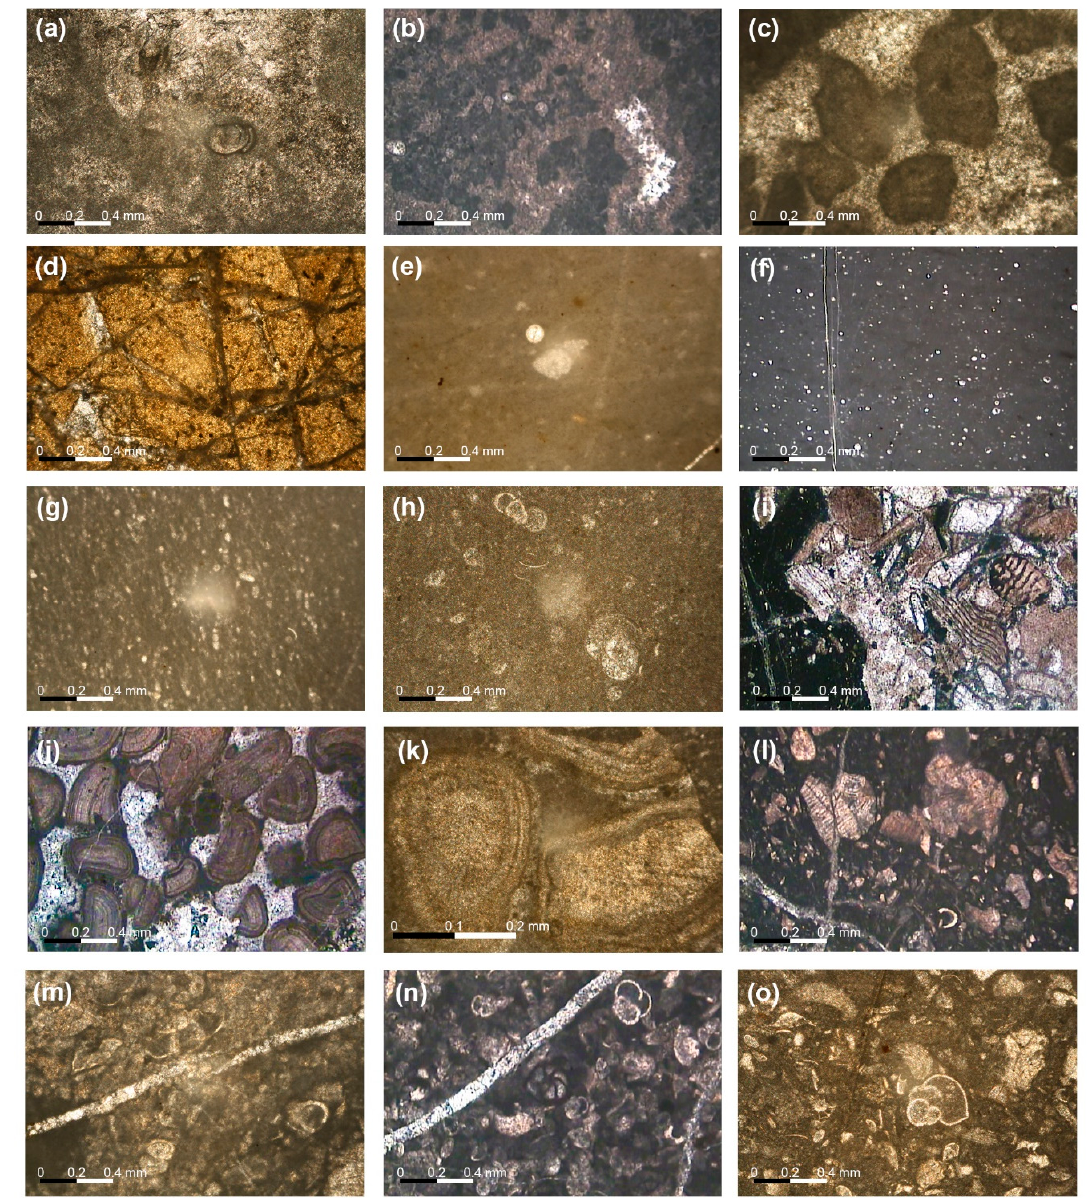
Figure 6. Characteristic Early Jurassic to Paleogene microfacies types of Ionian zone (Epirus region, NW Greece). ( a , b ) Dolomized boundstone with calcareous algae and benthic foraminifera within a micritic clotted matrix (samples AG1, AG15); ( c , d ) recrystallized grainstone of peloids with signals of dolomitization and fracturing (samples P3, P9); ( e ) mudstone-wackestone with radiolarian and planktonic foraminifera (sample P19); ( f , g ) wackestone with radiolarians (samples B1, B10); ( h ) Pelagic wackestone with radiolarians and planktonic foraminifera (sample K2); ( i ) Allochthonous bioclastic packstone with medium- and large-sized bioclasts benthics and rudist fragments (sample K5); ( j , k ) grainstone of ooids with sparitic cement (samples K4, K9); ( l ) bioclastic packstone of orientated and transported larger benthic foraminifera and rudists (sample A(2)7); ( m ) Pelagic wackestone-packstone of radiolarian and planktonic foraminifera, among which carenate forms are presented (sample A(2)9); ( n , o ) packstone with in situ planktonic foraminifera and scattered, transported benthics and molluscks (samples A7,